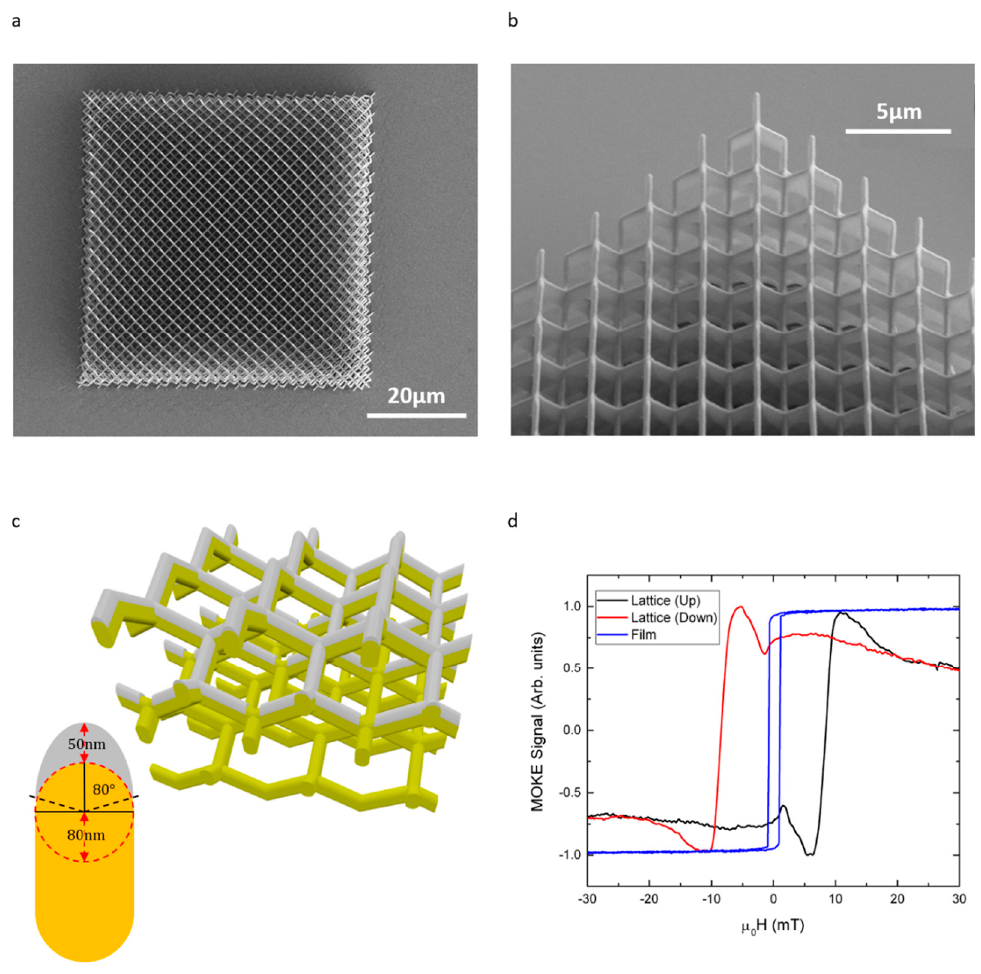
Figure 7. Structural and magnetic characterisation of a 3D N i81 Fe 19 nanowire lattice. ( a,b ) SEM images of the nanowire lattice observed from top view and a 45 ◦ tilt respectively; ( c ) Schematic of the Ni 81 Fe 19 nanowires (grey) upon a polymer sca ff old (yellow), where the e ff ects of shadowing by upper nanowire layers during LOS deposition is evident. Inset: Nanowire cross-sectional geometry; ( d ) MOKE data captured from the sheet film (blue) and nanowire lattice—this is separated into up-sweep (black) and down-sweep (red)